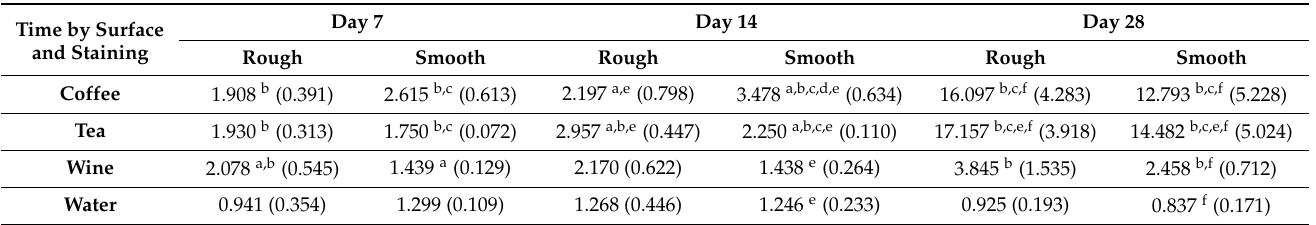
Table 4. NBS values for copolyester retainer specimens with different surface textures at different times after staining in different solutions (mean NBS value ± standard deviation).